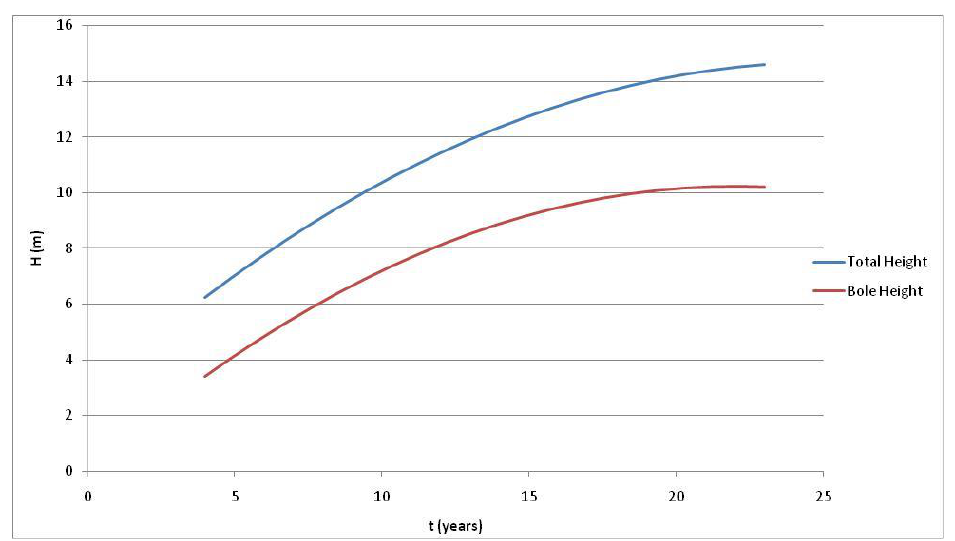
Figure 2. Height – age curves for Robinia pseudoacacia in the study area. Figure 2. Height–age curves for Robinia pseudoacacia in the study area.